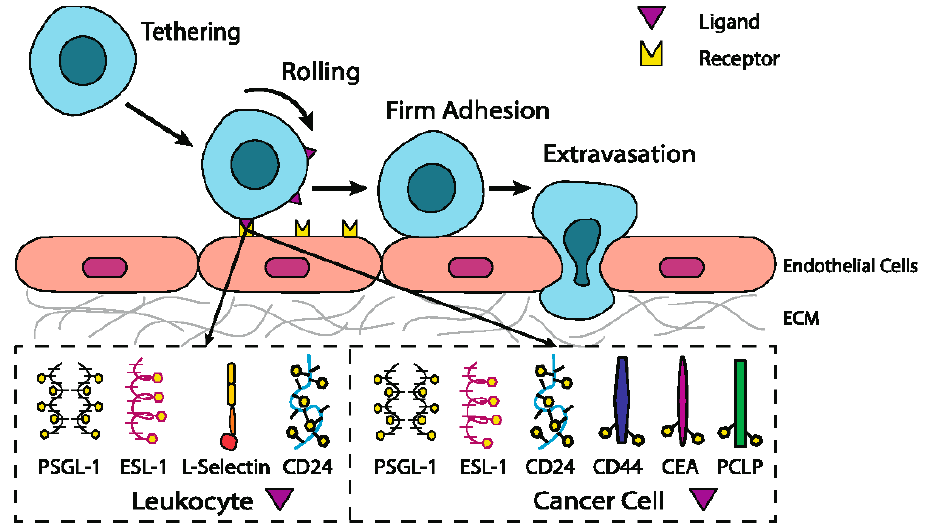
Figure 10. The leukocyte adhesion cascade and circulating tumor cells tethering, rolling, and firm adhesion on the endothelium share many paradigms. Most of the selectin ligands on leukocytes except L-selectin are also present on cancer cells. Recently, novel ligands on cancer cells have been observed to facilitate selectin-mediated rolling on the endothelium Reprinted with permission from [197]; copyright: Springer 2012.